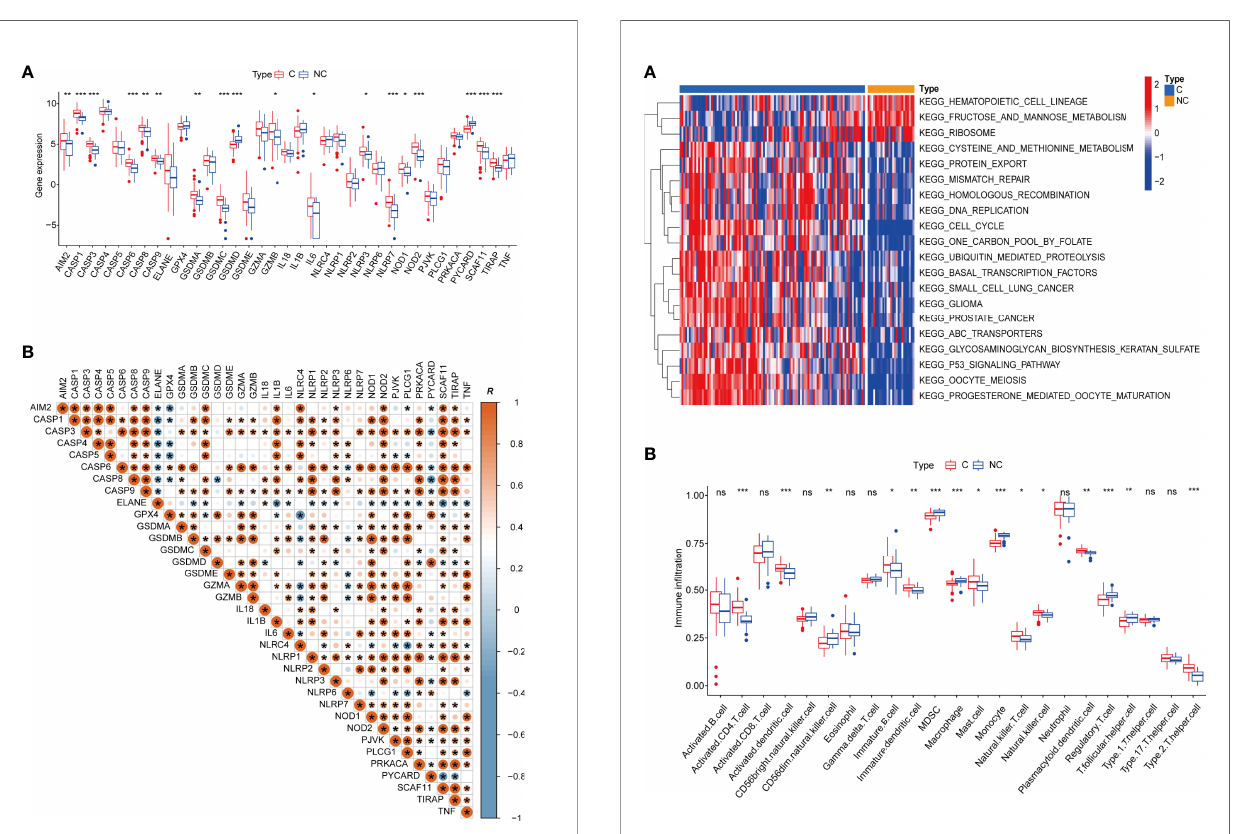
FIGURE 2 | (A) Gene set variation analysis (GVSA) analysis shows COVID-19 patients ’ leukocytes may have been signi fi cantly damaged during viral infection and are undergoing damage repair. C: COVID-19 patients; NC: none-COVID-19 patients. (B) The abundance of leukocytes between the different types of patients. *p < 0.05, **p < 0.01, ***p < 0.001, ****p < 0.0001, ns, no signi fi cance.